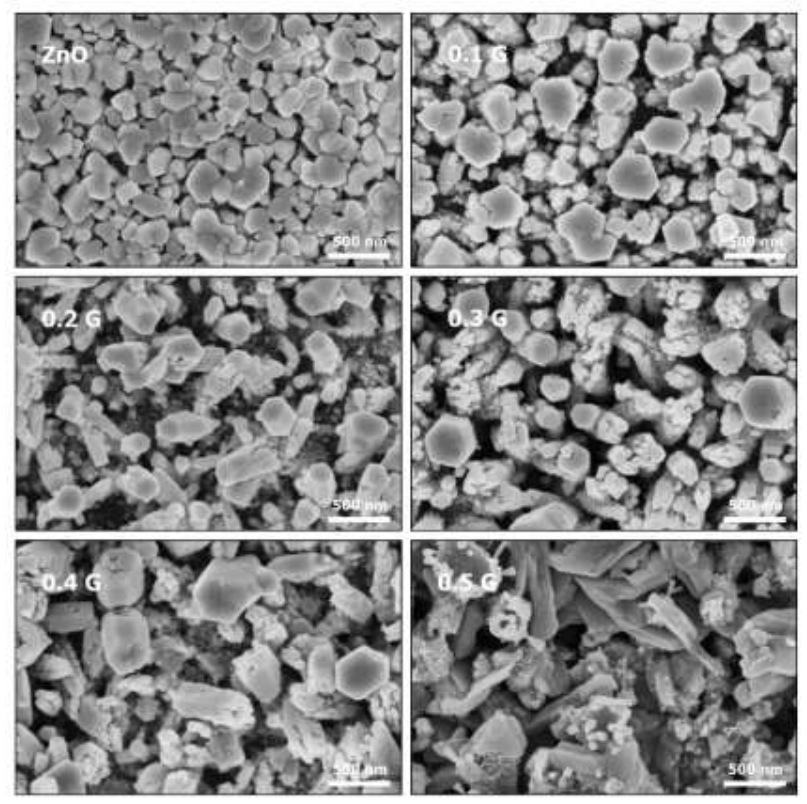
Figure 2: FESEM images of ZnO-G thin films morphologies with various graphene